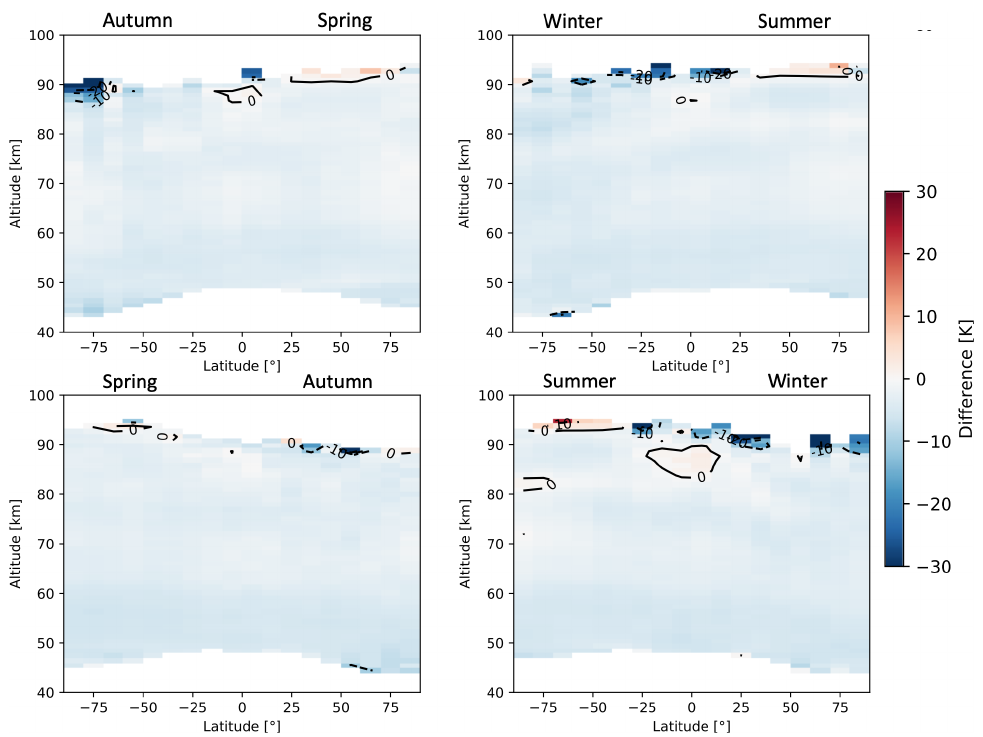
Figure A8. Seasonal zonal means of temperature FM13 SMR v3.0–v2.1 relative differences averaged over the whole time period between February 2001 and April 2019. The seasons are intended as astronomical seasons, i.e. each starting at the respective solstice or equinox.